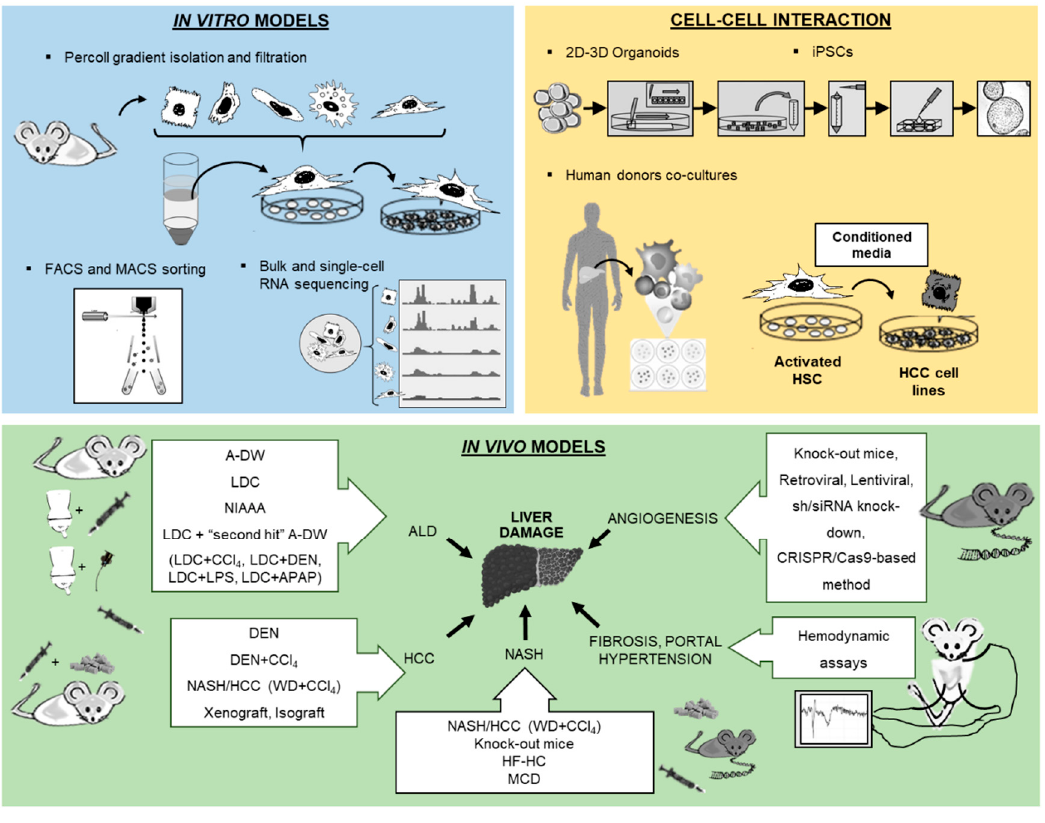
Figure 1. Overview of new methodologies using in vitro, cell–cell interaction and in vivo models for the study of liver pathology.